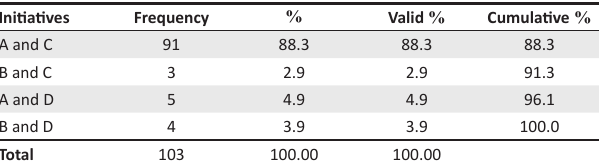
TABLE 1: Frequency and monitoring: Which pair of initiatives would you choose? Initiatives